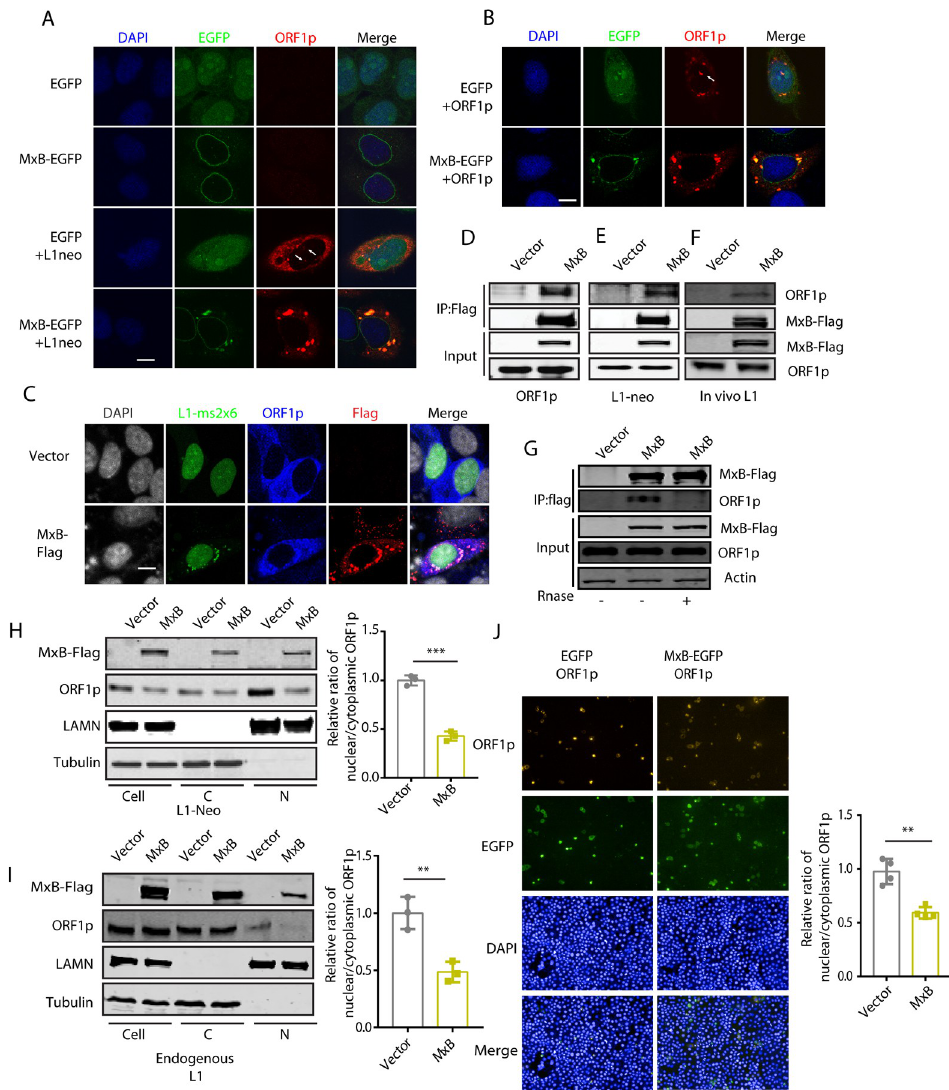
Fig 2. MxB interacts with ORF1p and sequesters LINE-1 RNP within the cytoplasm. (A) Immunofluorescence microscopy of MxB and ORF1p in HeLa cells which stably expressed MxB-EGFP and were transfected with CMV-L1-neo RT DNA. The white arrows indicate nuclear ORF1p. (B) Co-localization of stably expressed MxB-EGFP with ORF1p in HeLa cells that were transfected with ORF1p-Flag DNA. The white arrows show nuclear ORF1p. (C) Immunofluorescence microscopy of MxB and L1-ms2x6/MS2-GFP plasmids. The transcribed LINE-1 RNA contains six copies of MS2-binding site that are bound with MS2-GFP. The cytoplasmic punctate green fluorescence indicates localization of LINE-1 RNA. (D, E, F) Co-immunoprecipitation of transiently expressed MxB-Flag and ORF1p which was expressed either from the ORF1p-Myc DNA (D), the CMV-L1-neo RT DNA (E), or the endogenous LINE-1 in HEK293T cells (F). (G) Effect of RNase on co-immunoprecipitation of MxB and ORF1p. 293T cell were co-transfected with CMV-L1-neo RT vector and MxB-Flag. Co-IP was performed with or without RNase A. (H, I) Nucleocytoplasmic fractionation of HeLa cells transfected with the MxB DNA (48 hours). Presence of ORF1p, either ectopically expressed from the CMV-L1-neo RT DNA (H) or the endogenous form (I), in the nuclear (N) and cytoplasmic (C) fractions was detected by Western blots. In the Western blots, the nuclear fraction samples were from cells 5 times more than the cells of the cytoplasmic fraction samples. The intensities of protein bands were quantified and the results are presented in the bar graphs. To calculate the ratio of nuclear/cytoplasmic MxB, the amount of nuclear ORF1p normalized with the nuclear LAMN protein level, the amount of cytoplasmic ORF1p with tubulin, then nucleus/cytoplasm ORF1p ratio was calculated by dividing nuclear ORF1p value by the cytoplasm ORF1p value. At the end, the nucleus/cytoplasm ORF1p ratio of the vector control is arbitrarily set at “1”. N, nucleus; C, cytoplasm (mean ± SEM; paired t -test) (J) The Operetta High-Content Screen system (PerkinElmer) was utilized to detect the ORF1p fluorescence signals within the nuclei and the cytoplasm in HeLa cells which were transfected with MxB-EGFP and ORF1p-Flag. Ratios of the